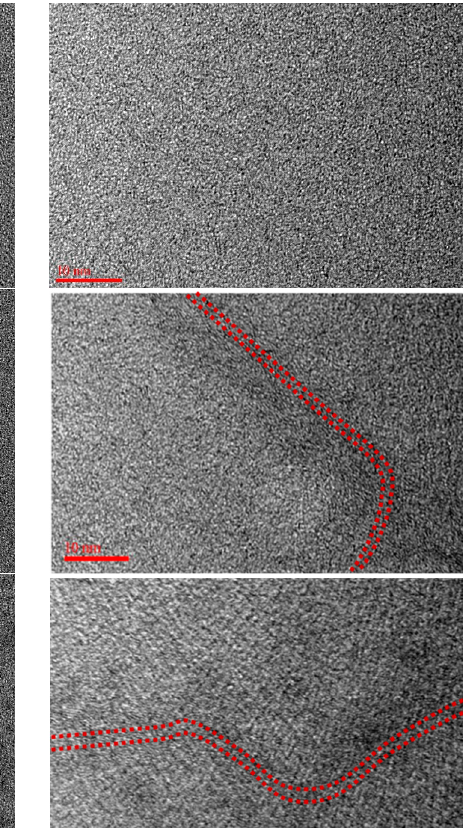
Figure 4. TEM images of PFO # -based carbon fibers: ( a ) PFO # and ( b , c ) PFO # /0.1 graphene .